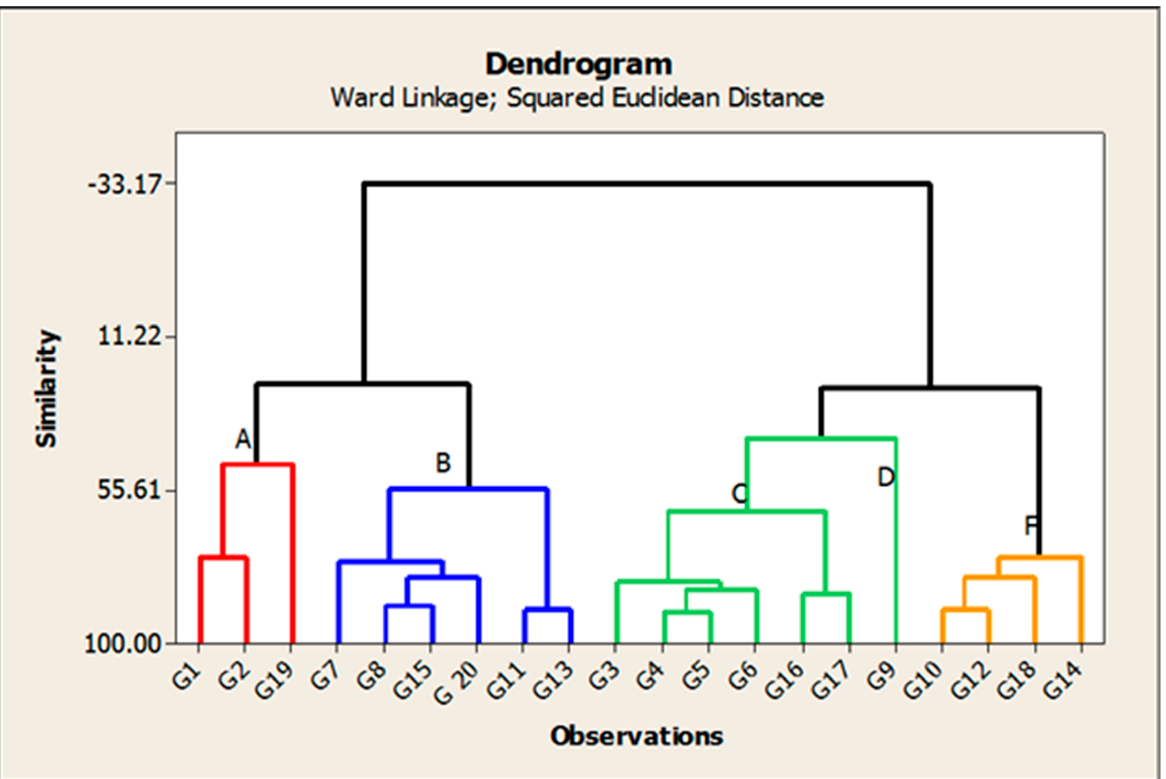
Figure 10. The dendrogram for the distance between the studied genotypes of rice based on yield and their components, as well as grain quality traits. Table 10. Summary of cluster analysis of the twenty genotypes of rice.